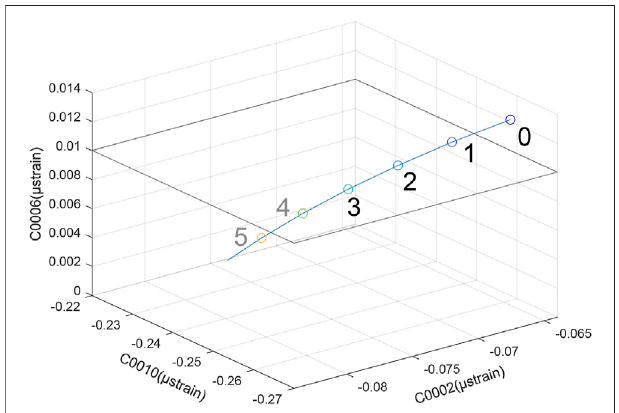
FIGURE 10 | 3-D view of volumetric strain changes for Pc1 at three boreholes asafunction ofdip angle in degree (numerals) forthe fault model